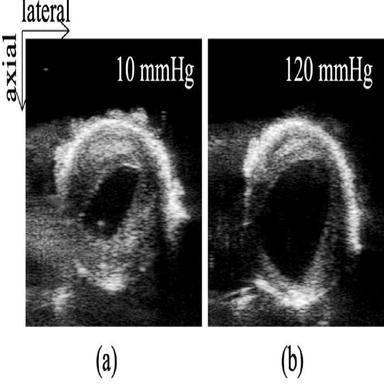
B-mode ultrasound images of a carotid cross section for at 10 mmHg (a) and 120 mmHg (b) pressures.